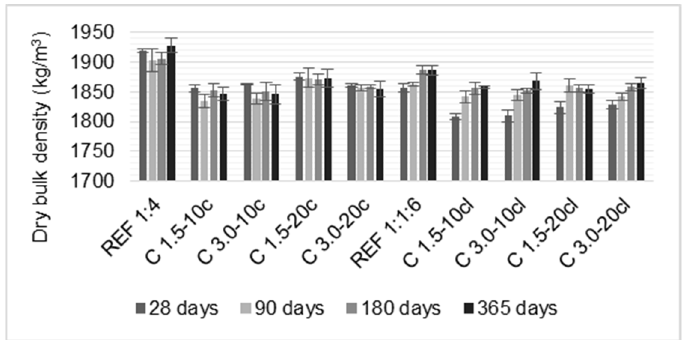
Figure 4. Flow table and bulk density test for coir fiber-reinforced cement mortar.